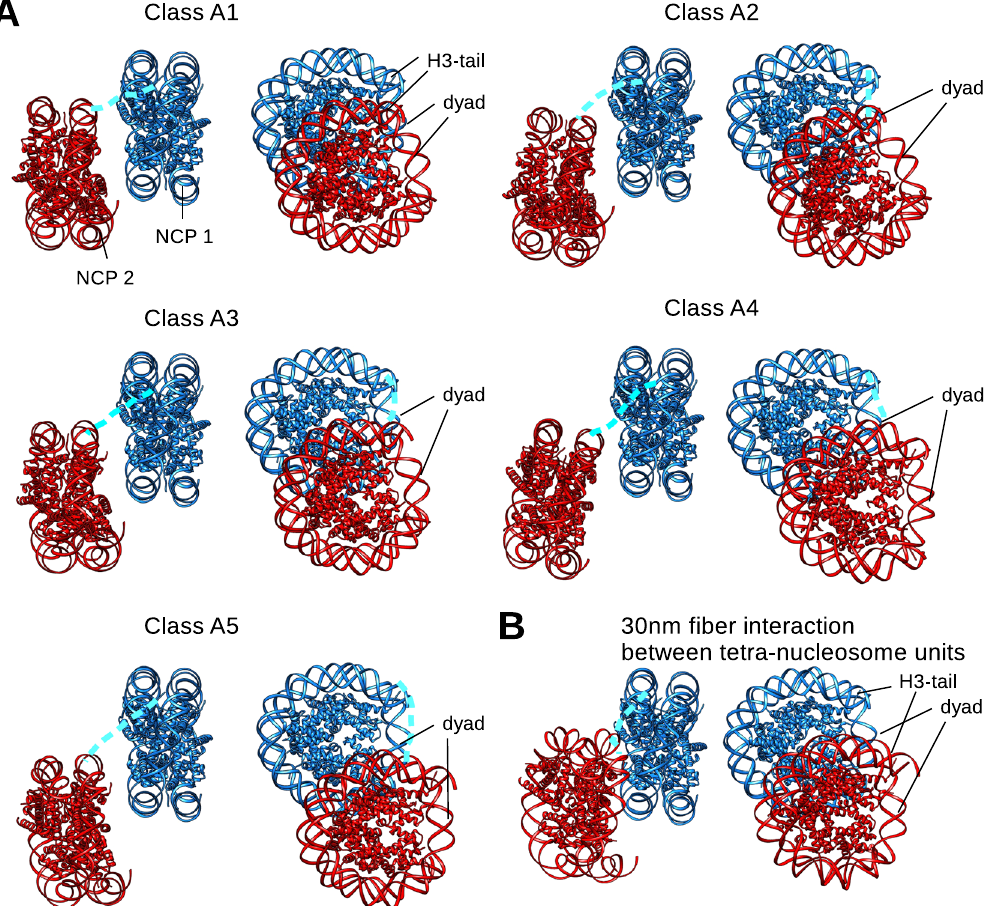
Figure 3. Molecular model showing long range NCP interactions. ( A ) Comparison of the NCP models for cryo-EM maps A1–A5. NCP 1 is shown in blue and NCP 2 is shown in red. The two NCPs are oriented with their histone octamers facing each other, but are shifted vertically to different degrees. The dyad of both NCPs is facing in the same direction. First 37 residues of the H3-tail, not observed in X-ray structure (pdb 3lz1), are indicated as a dotted line in light blue. In most classes, the histone octamer surface remains accessible to the extrinsic factors. ( B ) The model showing NCP orientation in the 30 nm fiber between adjacent tetra- nucleosomal units is included for comparison. The 30 nm fiber model was built using 30 nm fiber cryo-EM map 5